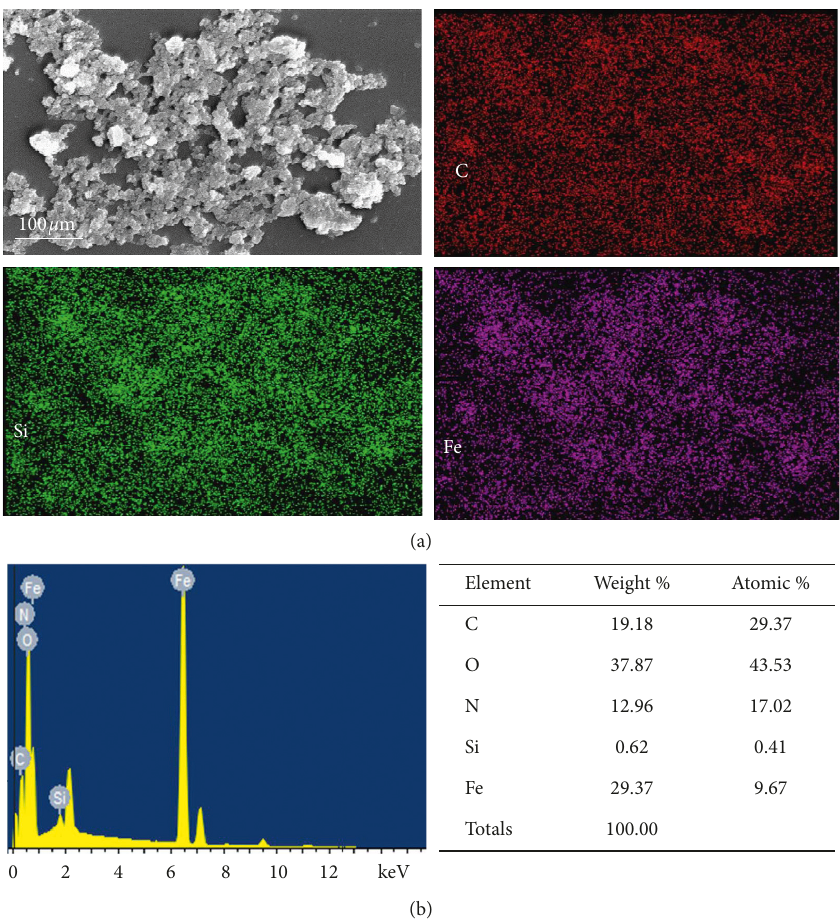
Figure 5: (a) SEM-mapping images of the distribution of various elements on the surfaces of SA@MNPs. (b) EDS spectrum and cor- responding relative elemental contents.